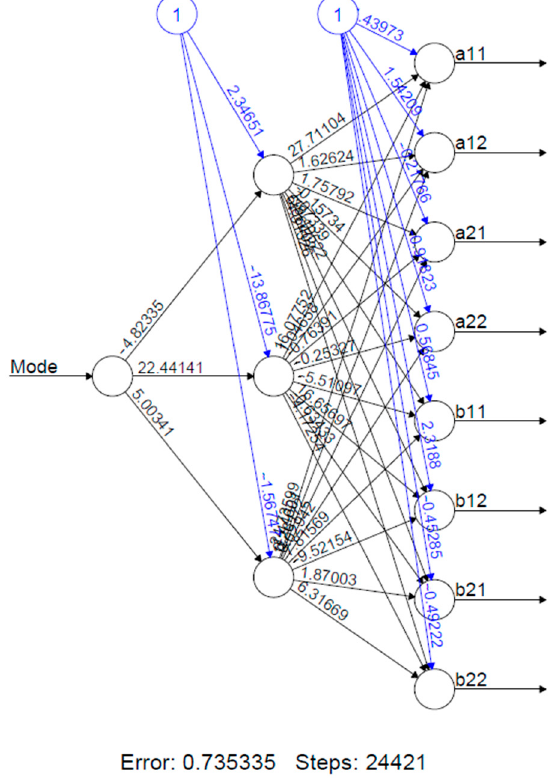
Figure 6. SIMO-neural network approximator of the coefficients of the dynamic model (20).